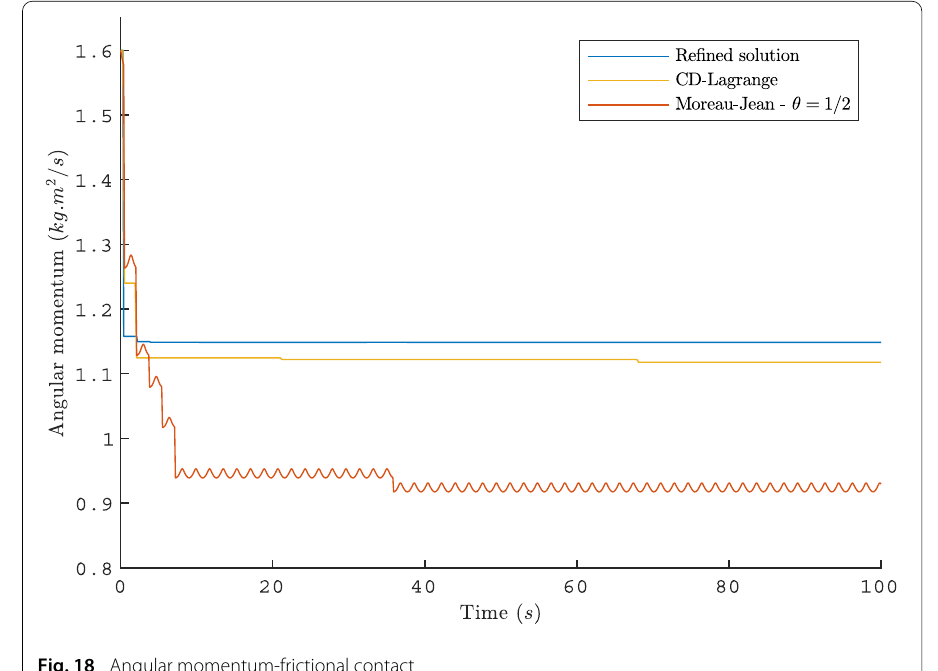
Fig. 18 Angular momentum-frictional contact